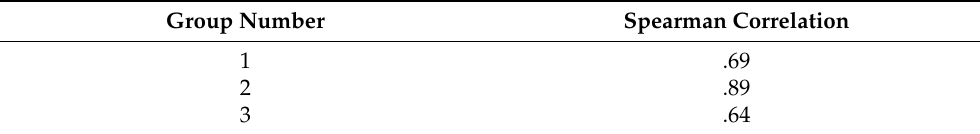
Table 4. Term-to-term evaluation results.